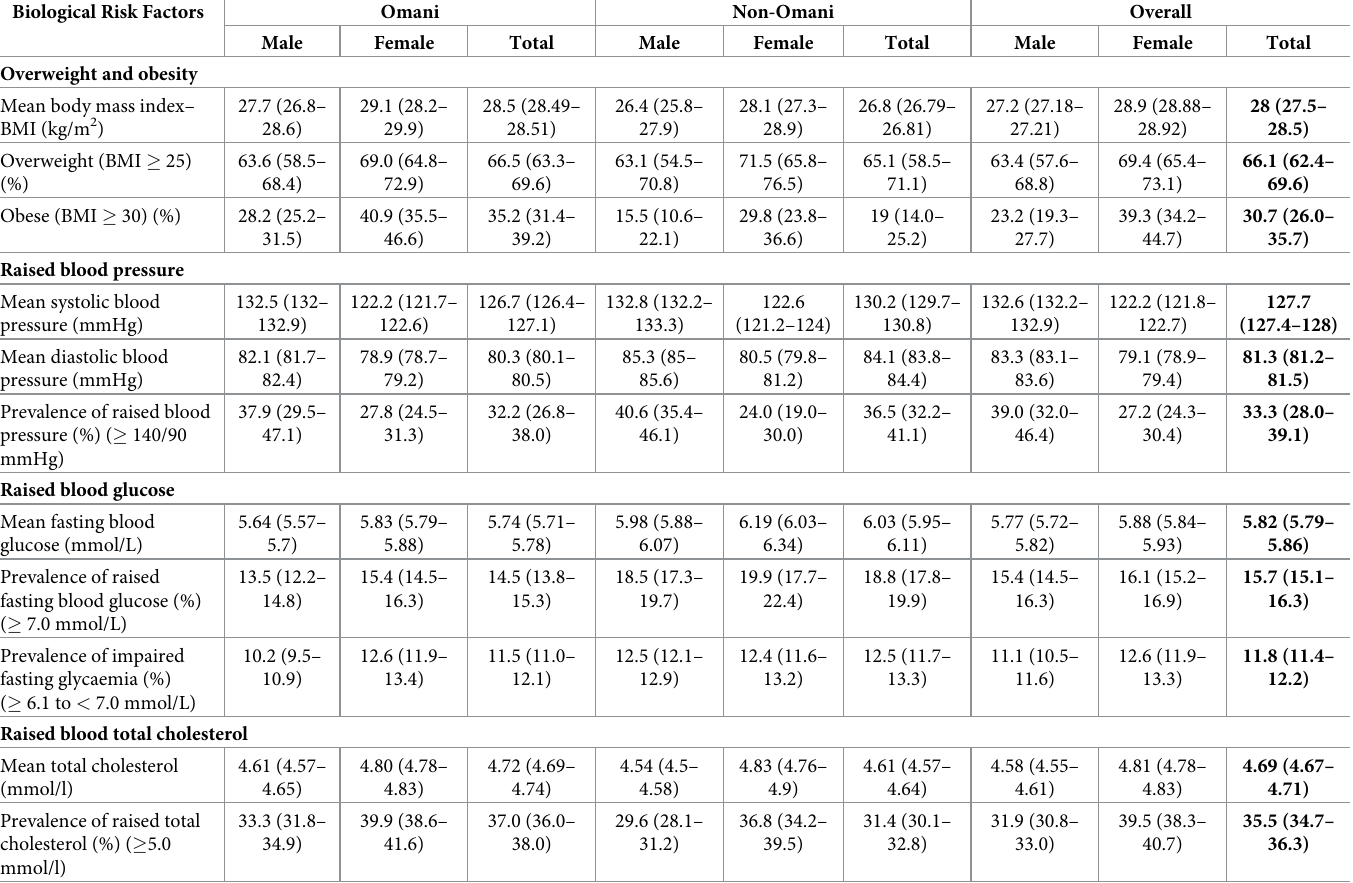
Table 3. Prevalence of biological risk factors of non-communicable diseases among the survey